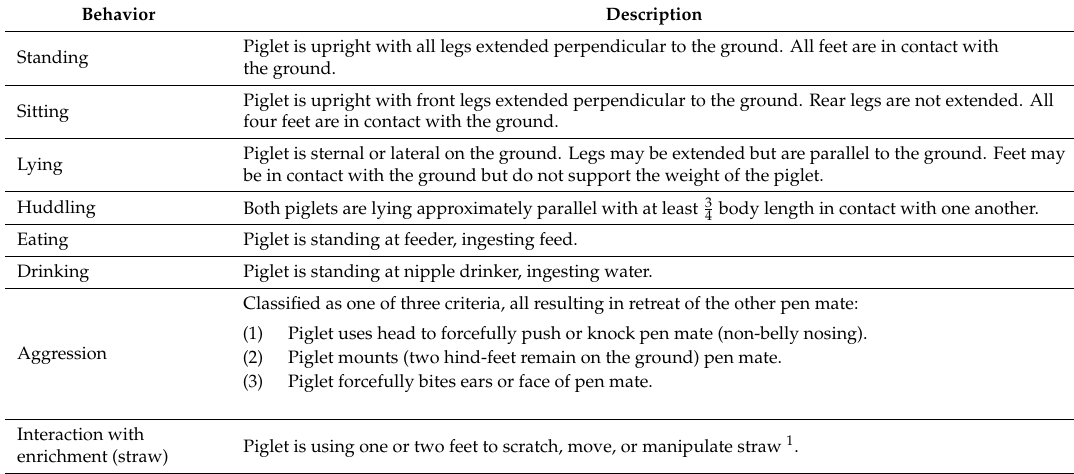
Table 1. Ethogram used for behavioral data